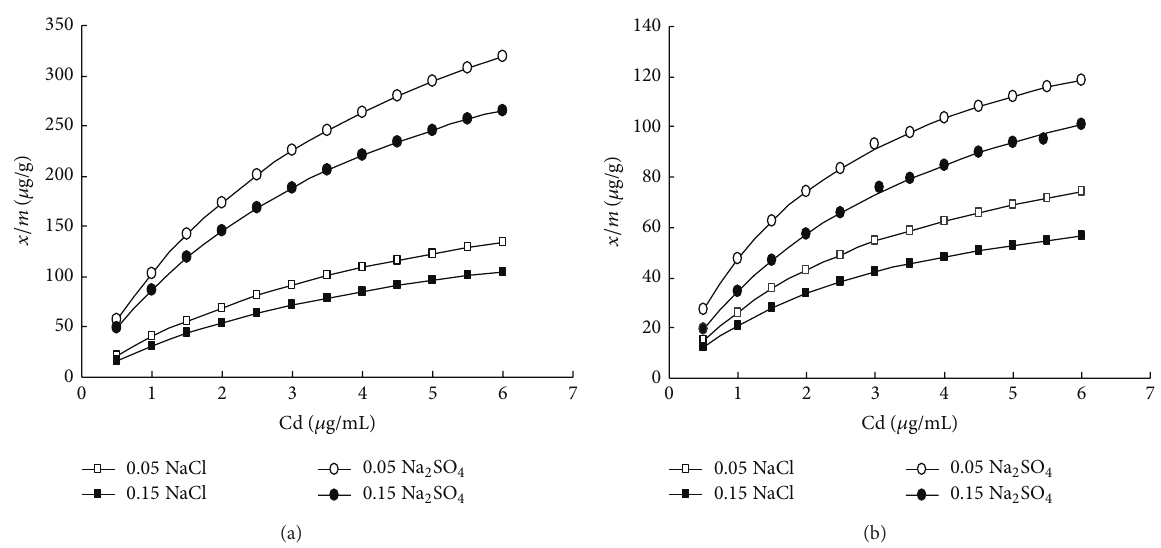
Figure 1: Cadmium adsorption isotherms by (a) alluvial soil and (b) calcareous soil, at different concentrations of NaCl and Na 2 SO 4 as electrolyte matrices. Empty circles are for 0.05 N, solid circles for 0.15N NaCl, empty squares for 0.05 NNa 2 SO 4 , and solid squares for 0.15 NNa 2 SO 4 .